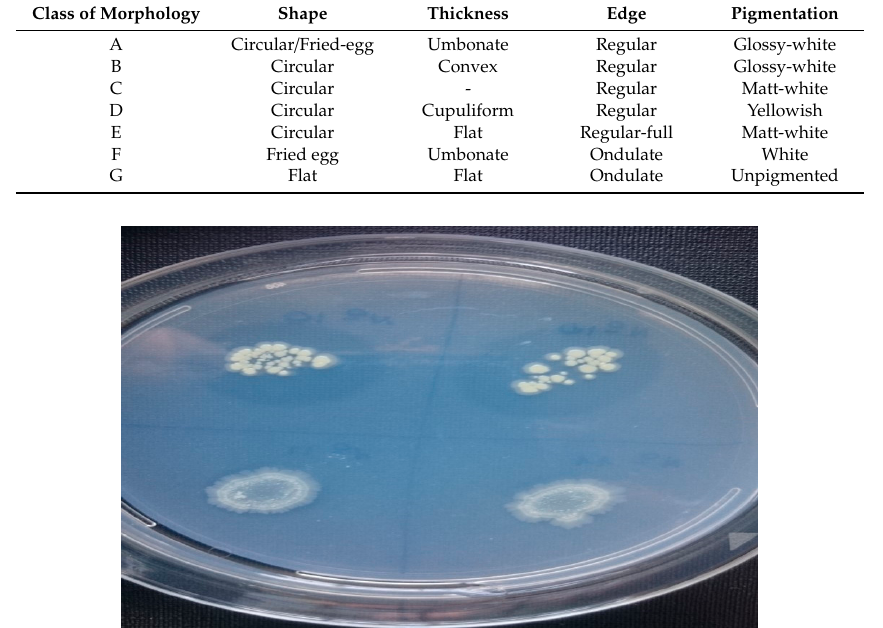
The selected isolates do not produce siderophores, and, except for PXI-4, P10-7 and P11-12, showed a weakly positive Gram reaction (Table 5). Twelve out of 35 bacterial isolates showed P-